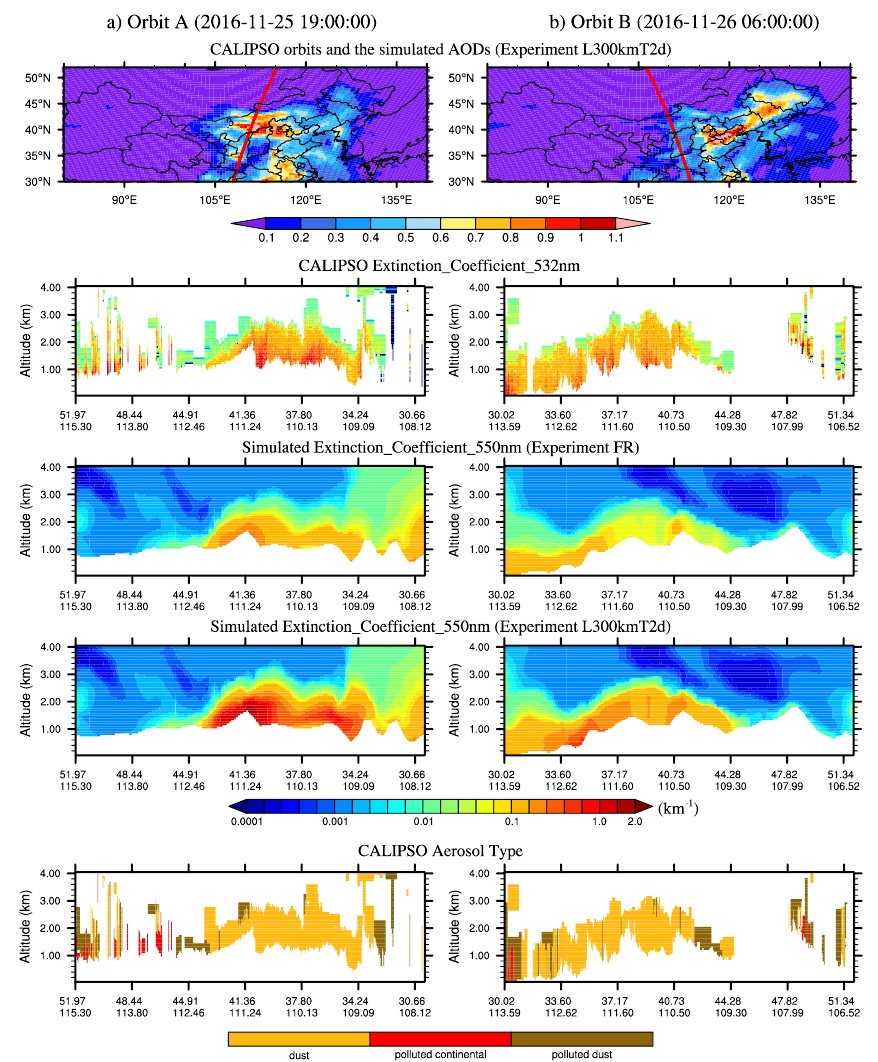
Figure 7. Comparisons of the model-simulated and Cloud-Aerosol Lidar and Infrared Pathfinder Satellite Observation (CALIPSO)-observed vertical aerosol extinction coefficients over two orbit paths. The first row shows the CALIPSO orbit paths and the horizontal distributions of the simulated AODs in the L300kmT2d experiment. The second row shows the CALIPSO-observed vertical aerosol extinction coefficients, whereas the third and fourth rows show the model-simulated ones with priori and posterior dust emissions. The bottom row shows the CALIPSO-detected aerosol types. ( a ) CALIPSO orbit at 19:00:00, 25 November 2016; ( b ) CALIPSO orbit at 06:00:00, 26 November 2016.